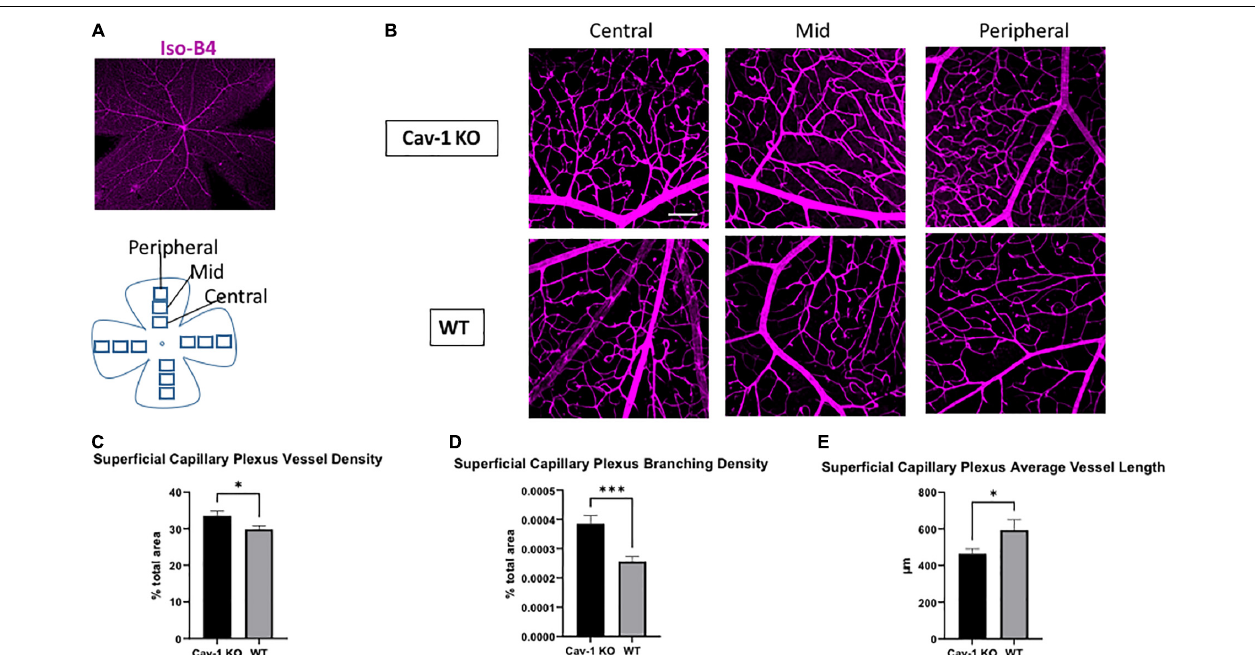
FIGURE 3 | Analysis of superficial capillary plexus morphology. (A) Representative image of flat-mounted retina stained with endothelial cell marker Isolectin-B4 (Iso-B4, magenta). (B) Iso-B4 staining at various eccentricities from the optic nerve head in flatmounted retina, scale bar in white indicates 100 µ m. (C,D) Cav-1 KO mice show increased superficial capillary plexus vessel density and branching density, compared to WT. (E) The average vessel length is the superficial capillary plexus is shorter in Cav-1 KO compared to WT, * p < 0.05, *** p < 0.001.